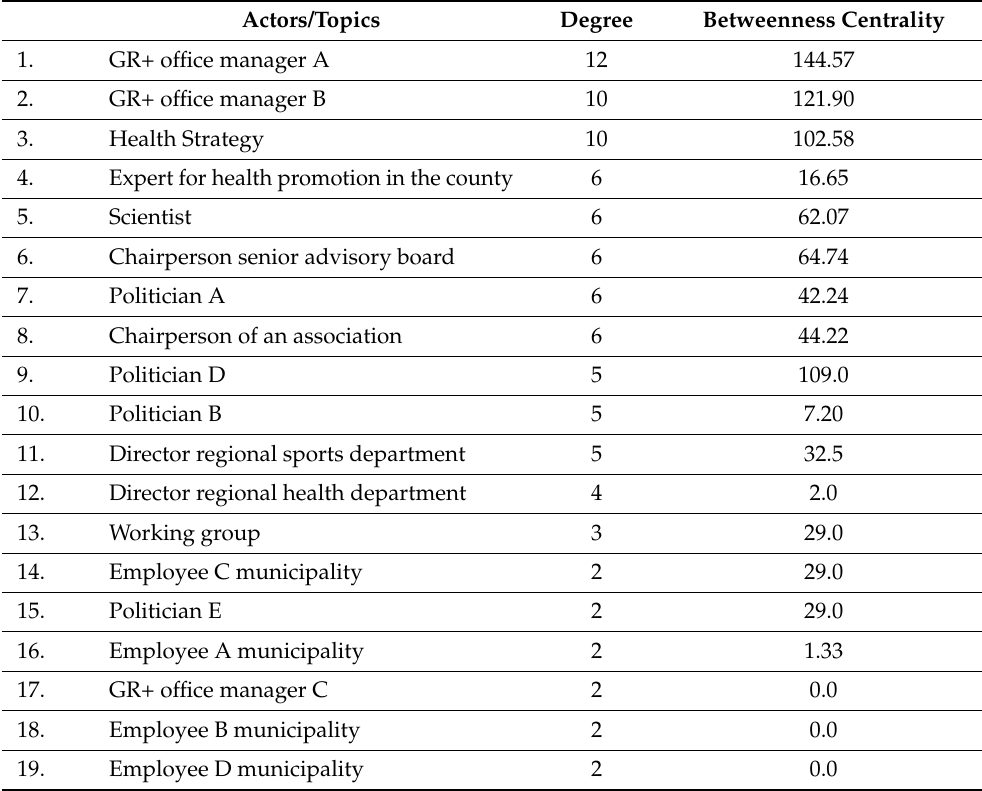
Table 2. Degrees and betweenness centrality as measured from the perspective of the project office managers; displayed are only actors with a degree > 1; Density =